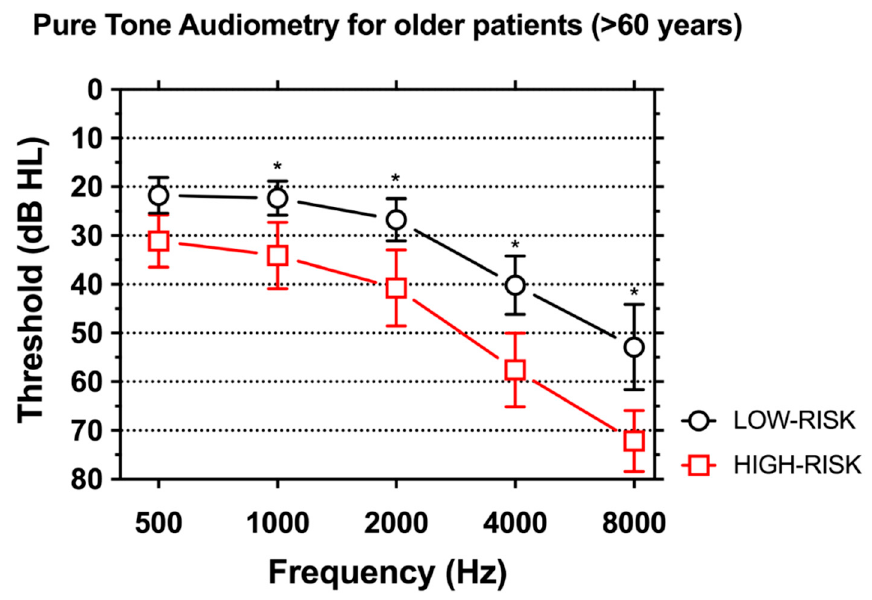
Figure 4. Comparison of pure tone audiometry thresholds in subjects older than 60 years in the LOW-RISK and HIGH-RISK groups. Significantly worse hearing was found in individuals in the HIGH-RISK group for all frequencies above 500 Hz ( p < 0.001). Asterisks indicate statistically-significant differences.